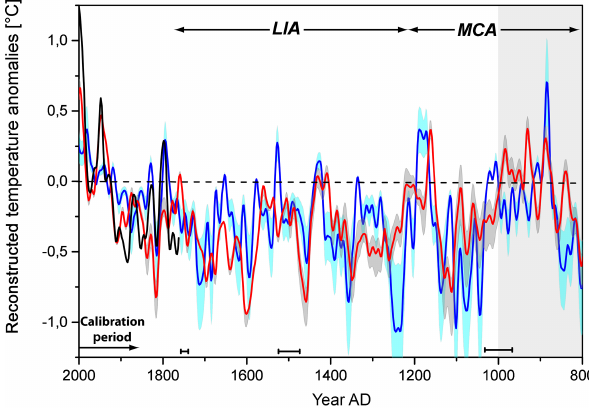
Figure 11. Comparison of decadal temperature trends as anomalies with respect to the mean of AD2006–1860. Shown are calibrated temperatures obtained from the KCC Ca 2 + variability (blue lines, with uncertainty indicated as light blue bands). Also shown are in- strumental temperature data (black) and the summer temperature re- construction of Luterbacher et al. (2016) in red (uncertainty as grey bands). Note that the overall co-variation between the two recon- structions persists for at least another 200 years beyond AD1000 (light grey shaded area). Black bars on the bottom indicate maxi- mum dating